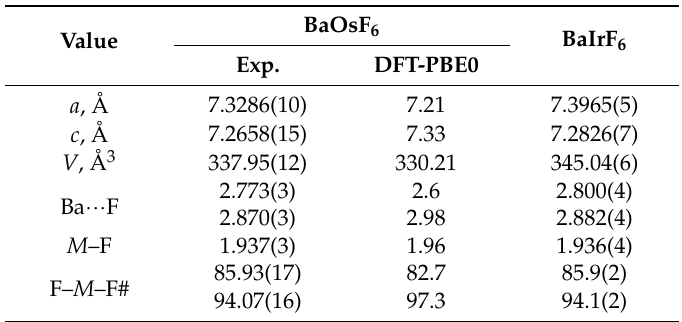
Table 3. Selected crystallographic data for BaOsF 6 and BaIrF 6 [34].